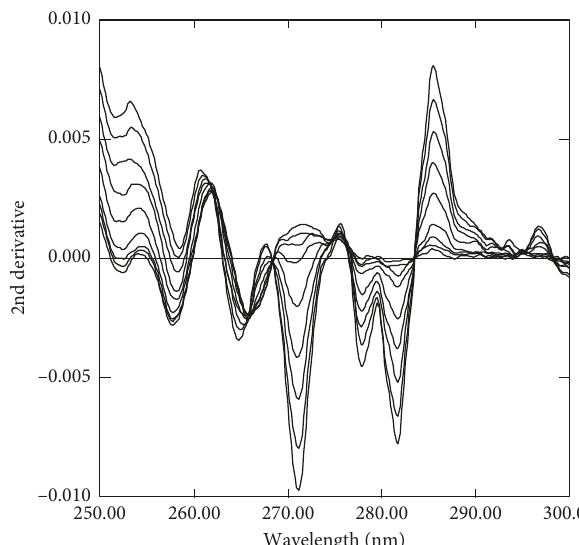
Figure 7: Second derivative spectra of mixture containing 1, 2, 3, 5, 10, 15, 20, 25, and 30 μ g · mL − 1 pyriproxyfen and 3.0 μ g · mL − 1 chlorothalonil.